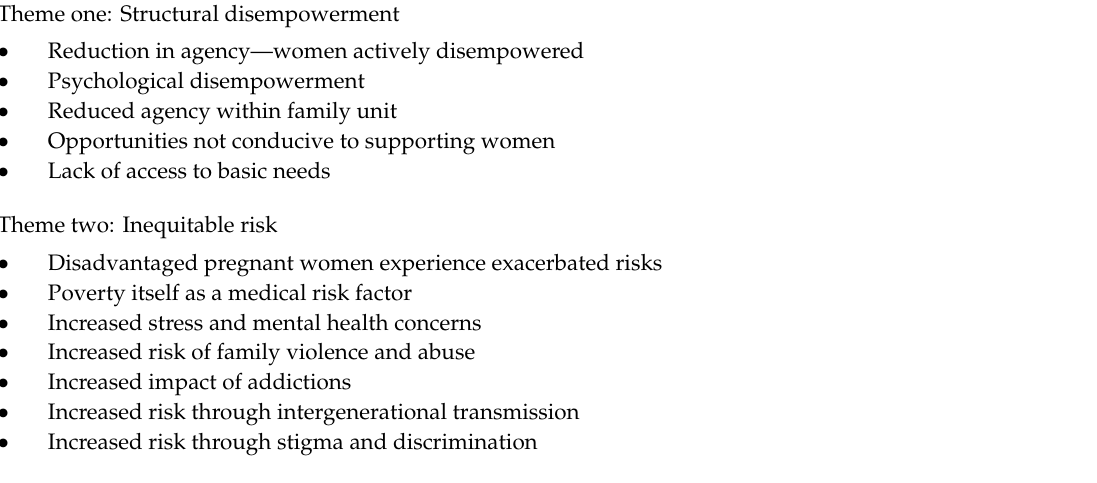
Table 1. Overview of